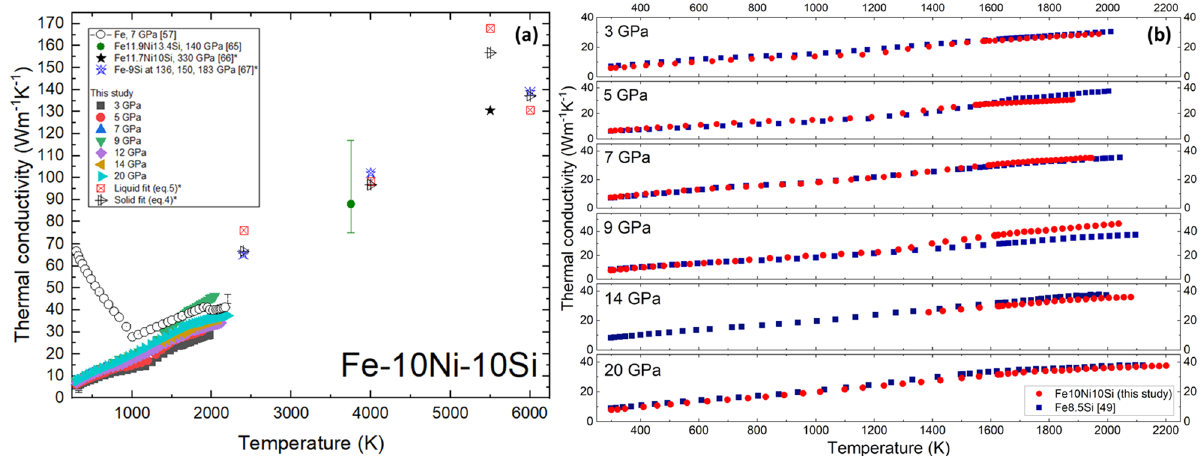
Figure 4. ( a ) Thermal conductivity of Fe10Ni10Si as a function of T . Results are compared with Fe at 7 GPa 57 , solid Fe11.9Ni13.4Si at 140 GPa 65 , solid Fe11.7Ni10Si at 330 GPa 66 , and solid Fe9Si at 136–183 GPa 67 . Equation (4) is used to calculate k e of solid Fe10Ni10Si, as shown by the black triangles, at the P , T conditions of Zidane et al. 66 and Zhang et al. 67 , shown with black and blue stars respectively. Equation (5) is used to calculate k e of liquid Fe10Ni10Si, as shown by the red squares. The * denotes calculations. ( b ) Thermal conductivity of Fe10Ni10Si compared to Fe8.5Si at common P from 3 to 20 GPa 49